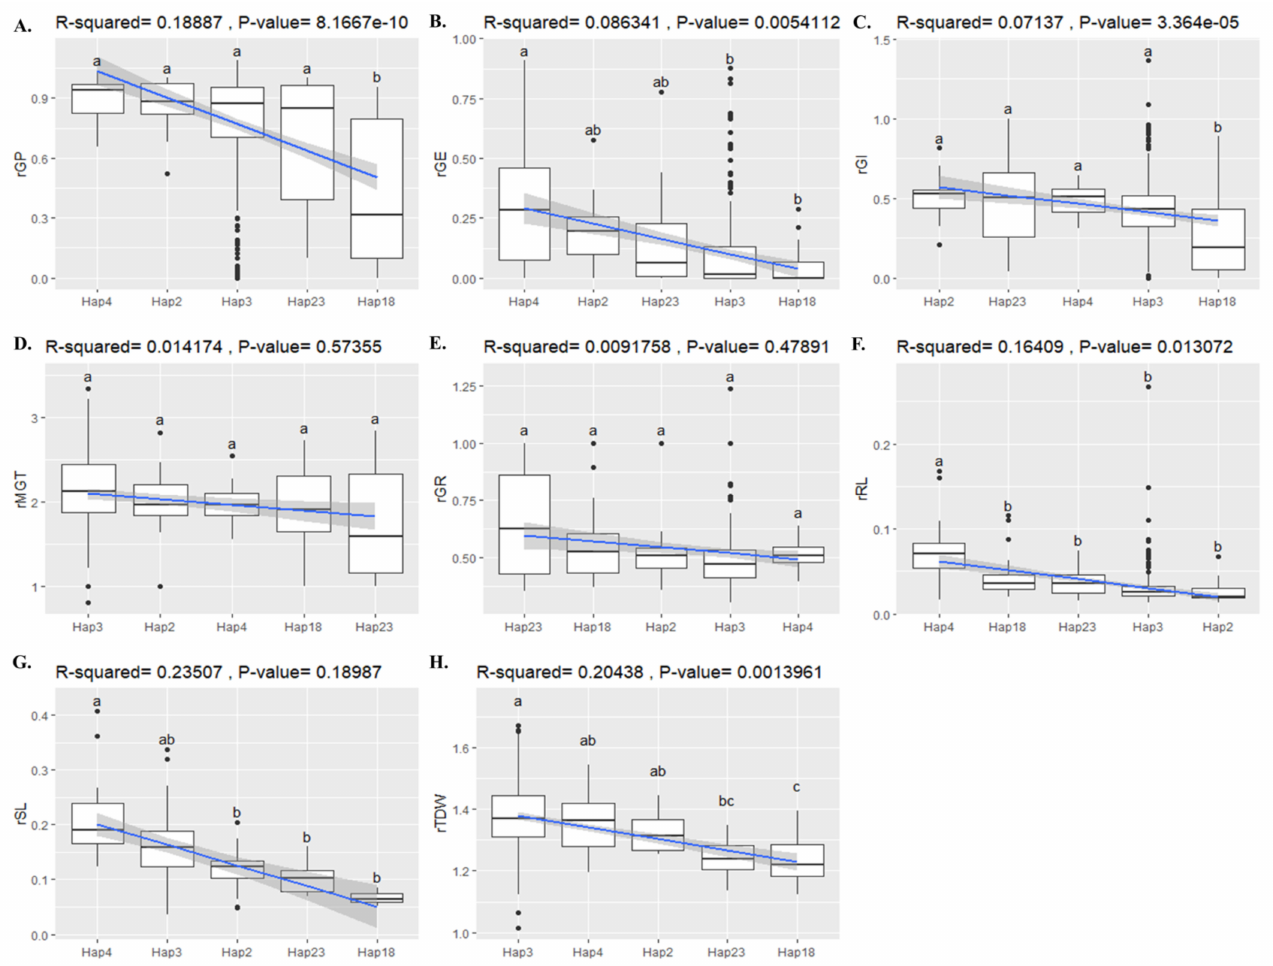
Figure 7. Association of selected BADH1 haplotypes and eight plant parameters under salt treatment. ( A – H ) Relative variations of salt tolerance-related traits among the selective predominant haplotypes, indicating significant level by statistical test. The order of these predominant haplotypes was sorted (from left to right) by their relative/statistical mean value (from highest to lowest) of each trait. Among the previously identified 39 haplotypes of cultivated rice, only five predominant haplotypes were selected for comparison in association to each salt tolerant parameters due to the rice accession number to which they belonged. For association level to each plant parameter, the selected haplotypes were compared by using Scheffe’s test at a significant level ( p -value < 0.05). Abbreviations: rGP, relative germination percentage; rGE, relative germination energy; rGI, relative germination index; rGMT, relative germination mean time; rGR, relative germination rate; rRL, relative root length; rSL, relativce shoot length; rTDW, relative total dry